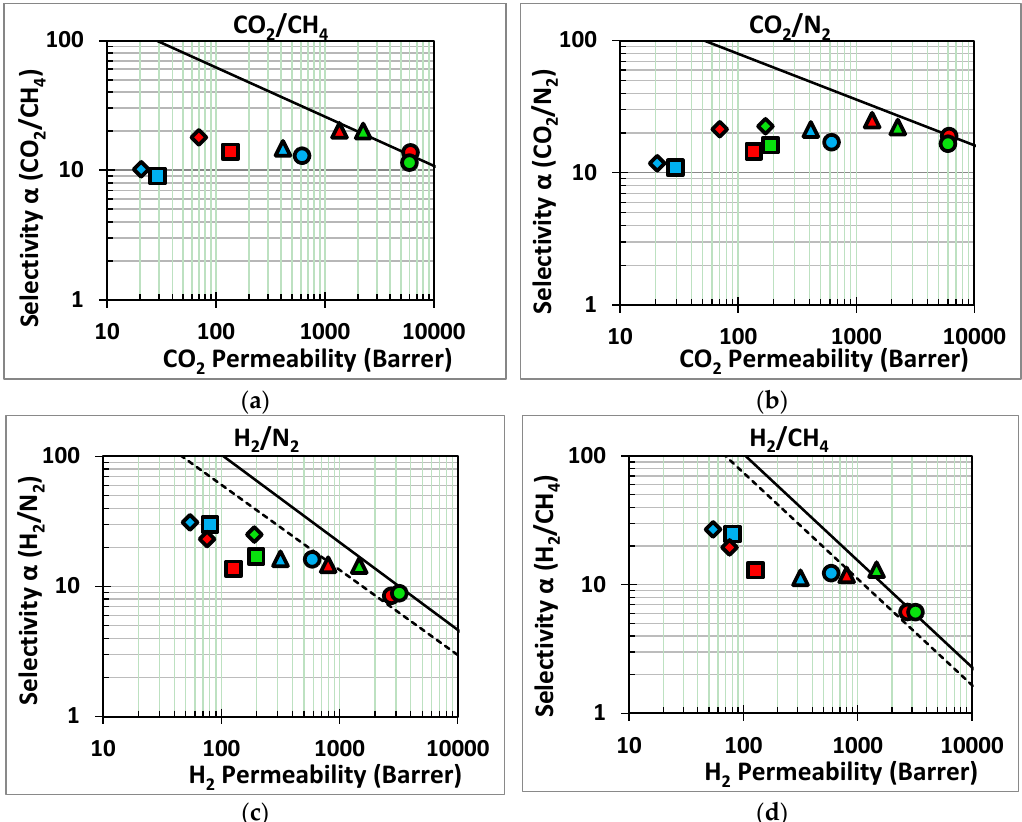
Figure 9. Robeson’s plots for four gas pairs of industrial interest. The dashed line and the solid line represents the Robeson 1991 upper bound [1] and the 2008 upper bound [2], respectively. Red series: neat PIM-1 ( ) and ZIF-8/PIM-1 after 1( ), 5( ) and 10( ) growth cycles; Green series: AMD-PIM1